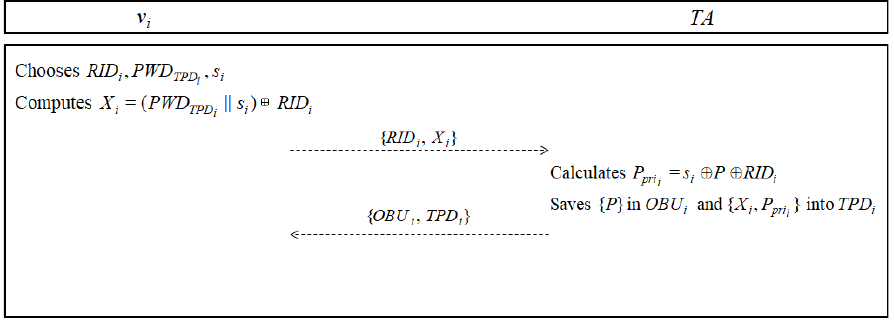
Figure 2. Formation phase of Limbasiya et al.’s protocol.